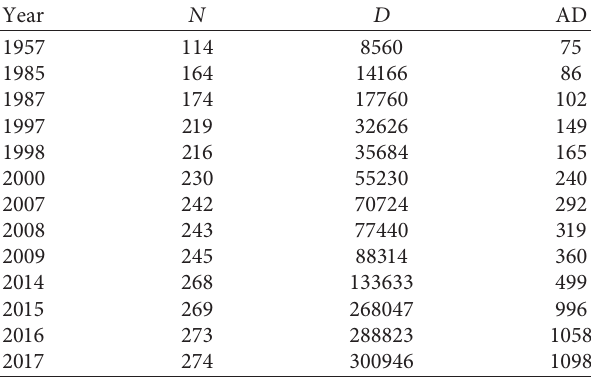
Table 1: Scale characteristic indicators of China railway